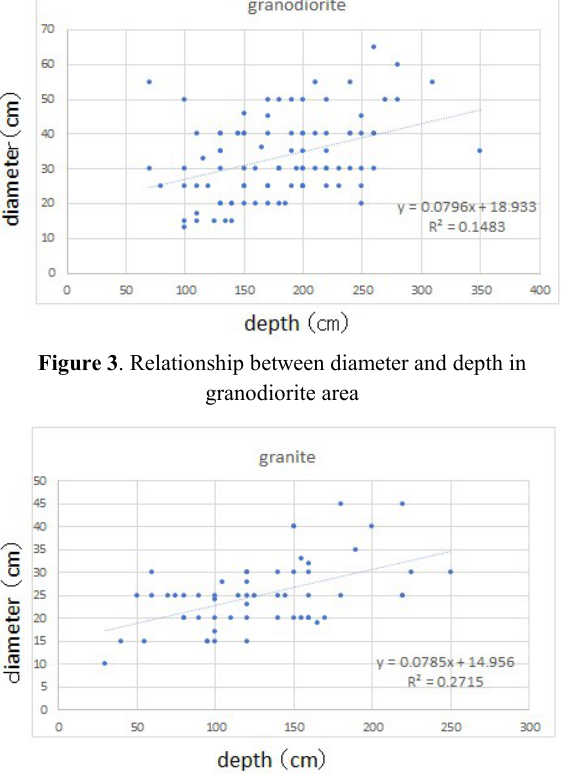
Figure 4 . Relationship between diameter and depth in granite